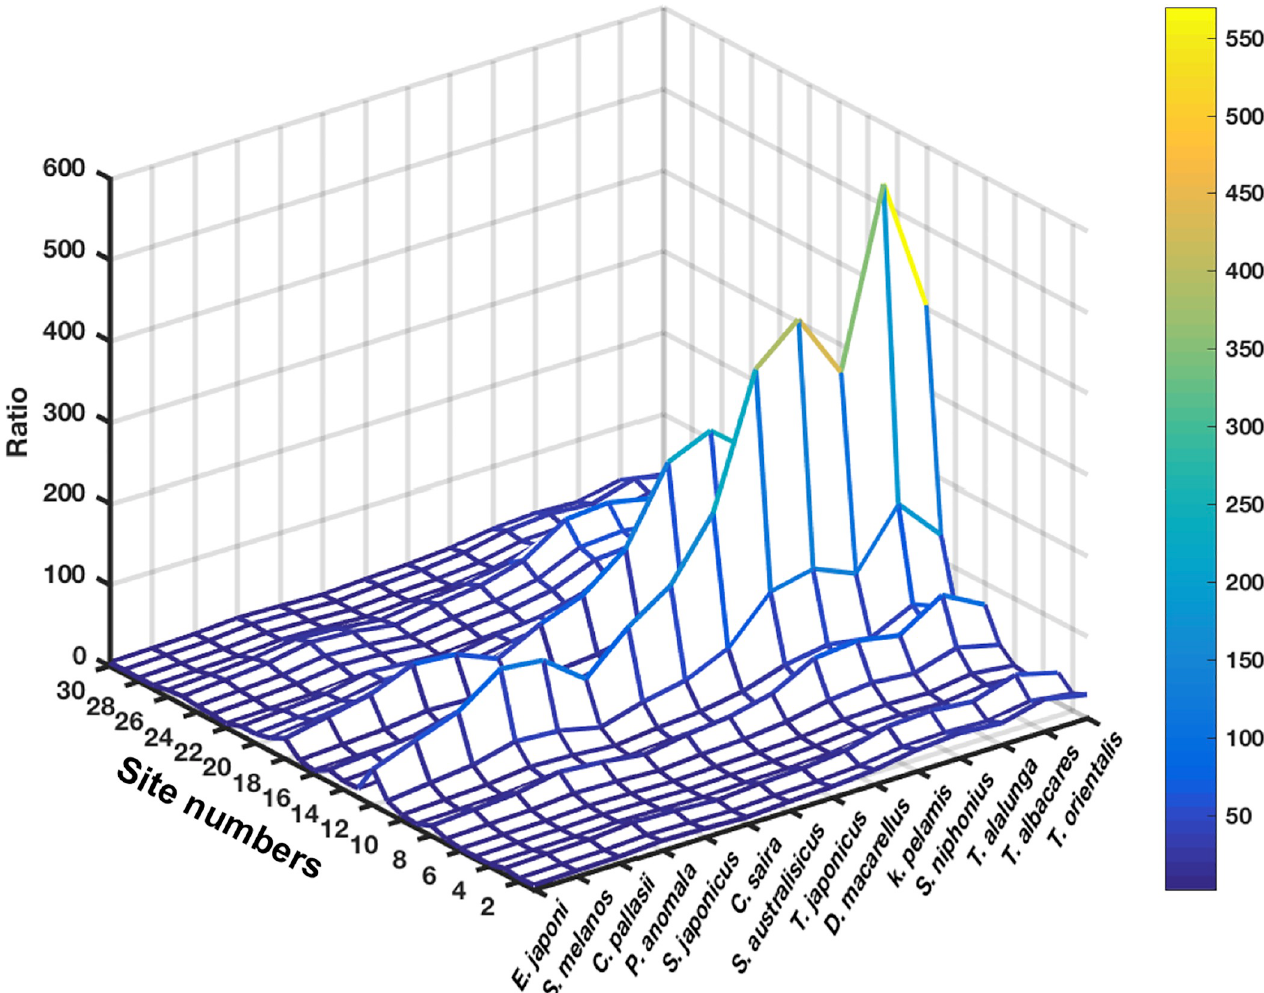
Fig 13. Ratio between the 137 Cs activity concentration in the organism at the end of the simulation (28 Feb 2013) and the activity concentration in the same organism two years before (28 Feb 2011), shown as function of studied species (x-axis) and sites (y-axis). The studied species are shown in an increasing order of their asymptotic